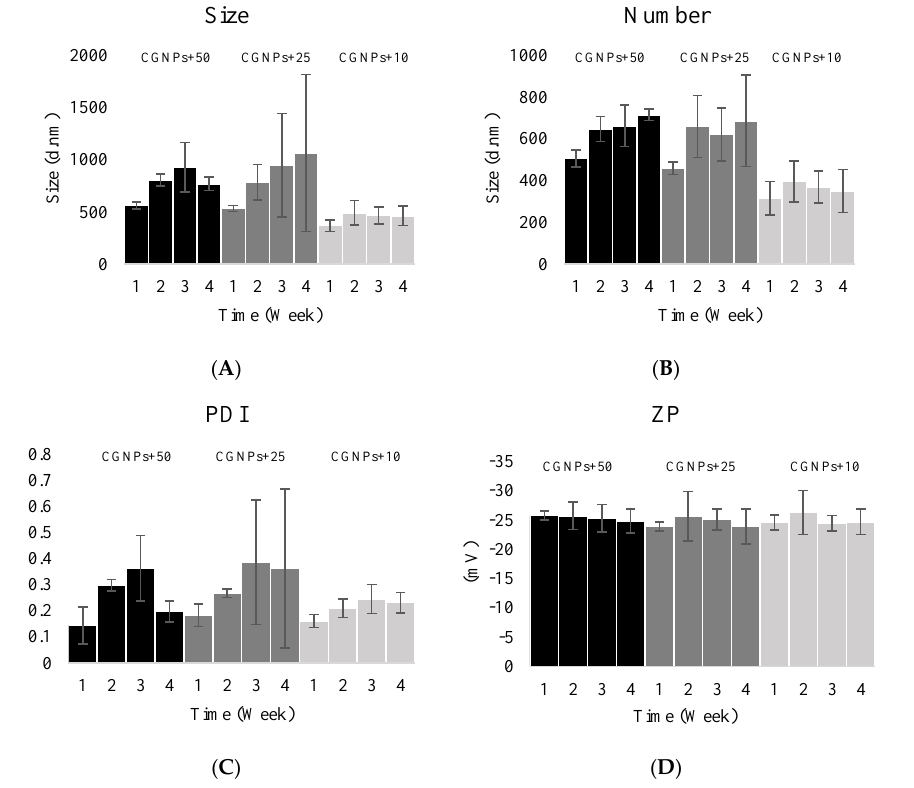
Figure 3. Physicochemical stability of CG particles with different concentrations of α -tocopherol in 30 days: ( A ) Size, ( B ) Number, ( C ) PDI and ( D ) ZP. Data represent mean ± standard deviation of n = 3; Where: CGNPs+50 = cashew gum nanoparticle with 50% of α -Tocopherol; CGNPs+25 = cashew gum nanoparticle with 25% of α -Tocopherol; CGNPs+10 = cashew gum nanoparticle with 10% of α -Tocopherol; PDI = polydispersity; ZP = Zeta Potential.